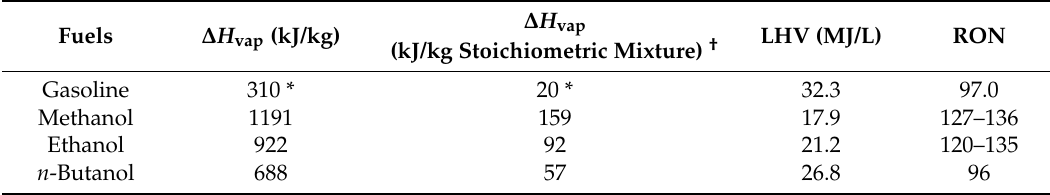
Table 2. Summary of different oxygenates and their compounds